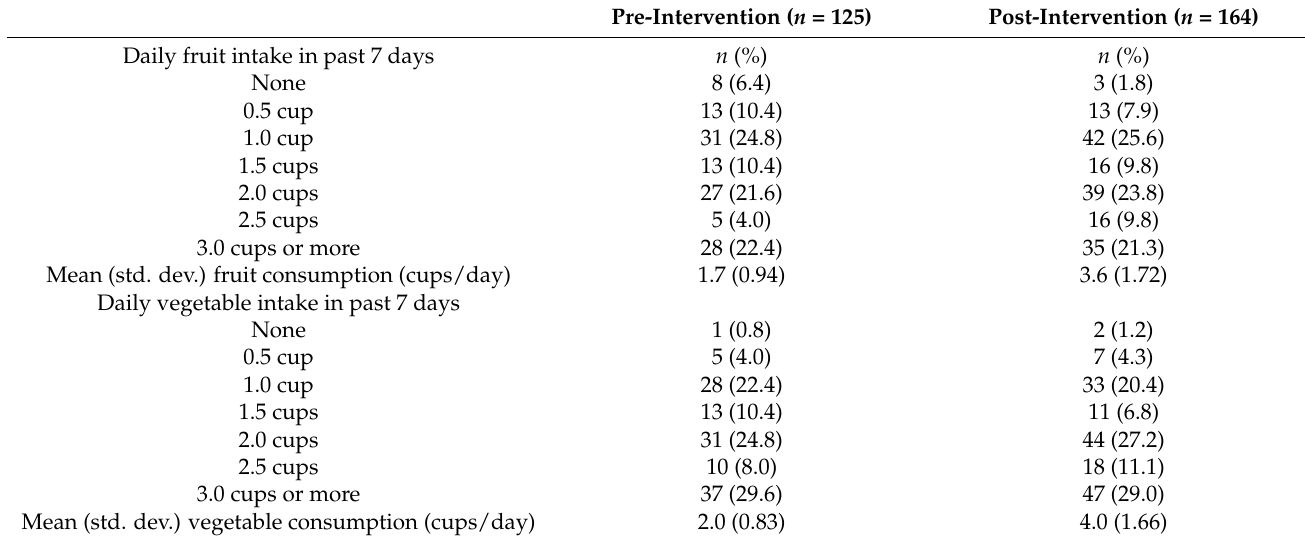
Table 4. Daily fruit and vegetable intake pre- and post-intervention: comparison of two points in time. Pre-Intervention ( n =